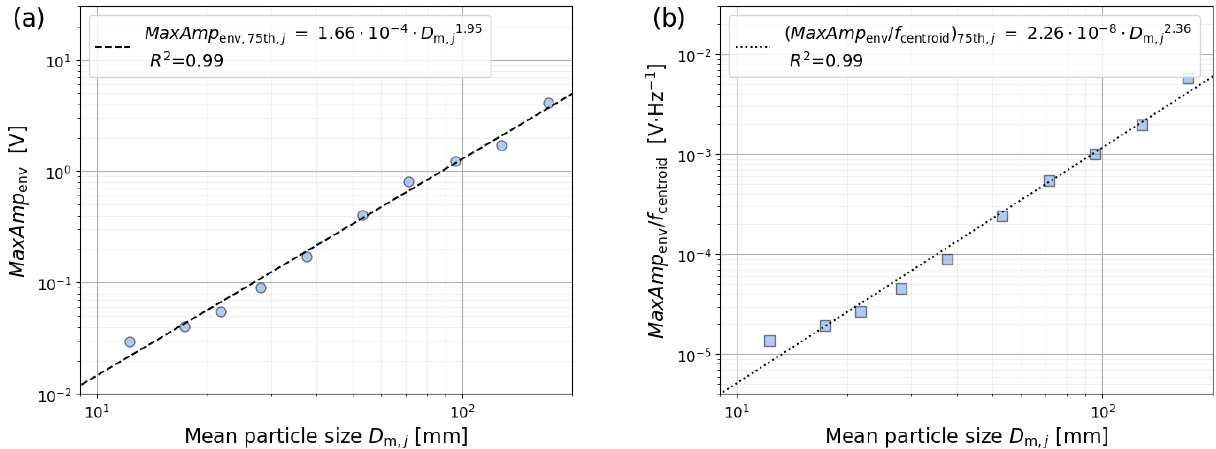
Figure 4. Power-law least-squares regression relationships between the mean particle diameter D m ,j and the 75th percentile of the packets’ amplitude MaxAmp env , 75th ,j (a) and amplitude–frequency (MaxAmp env /f centroid ) 75th ,j (b) values obtained from the single-grain-size experiments after filtering out apparent packets using the filtering criterion in Eq.